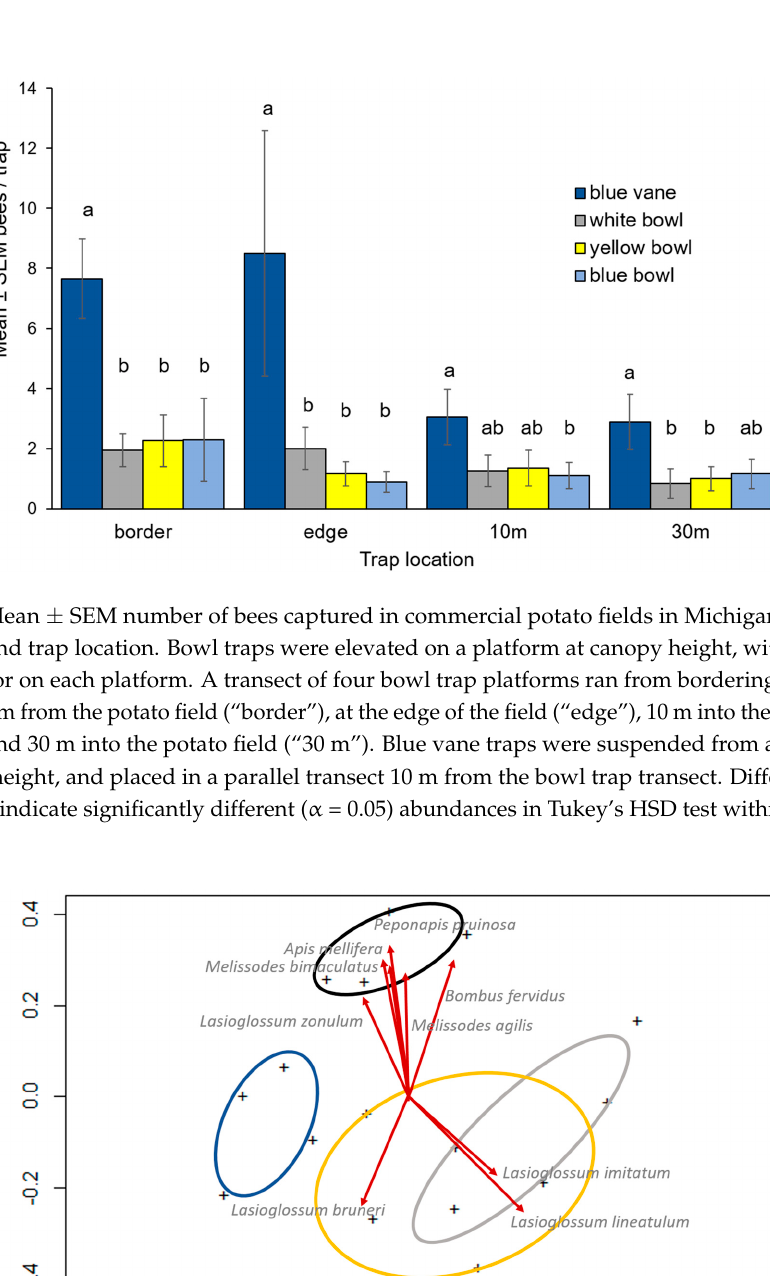
Figure 4. Visualization of bee communities by trap type in non-metric multidimensional ordination space. Bowl traps were elevated on a platform at canopy height, with one bowl of each color on each platform. A transect of four bowl trap platforms ran from bordering vegetation roughly 10 m from the potato field (“border”), at the edge of the field (“edge”), 10 m into the potato field (“10 m”) and 30 m into the potato field (“30 m”). Blue vane traps were suspended from a metal rod at canopy height, and placed in a parallel transect 10 m from the bowl trap transect. Bee communities (+) are the sum of individuals found in each trap type and location, summed across sites and dates. Ellipses represent 95% confidence intervals around communities defined by trap type: blue vane trap (black ellipse), blue bowl trap (blue ellipse), white bowl trap (grey ellipse), and yellow bowl trap (yellow ellipse). Bee communities did not differ across trap locations; 95% CIs for trap location are not presented. Red vectors are species with significant ( p < 0.05) effects in the ‘adonis’ model (see text for